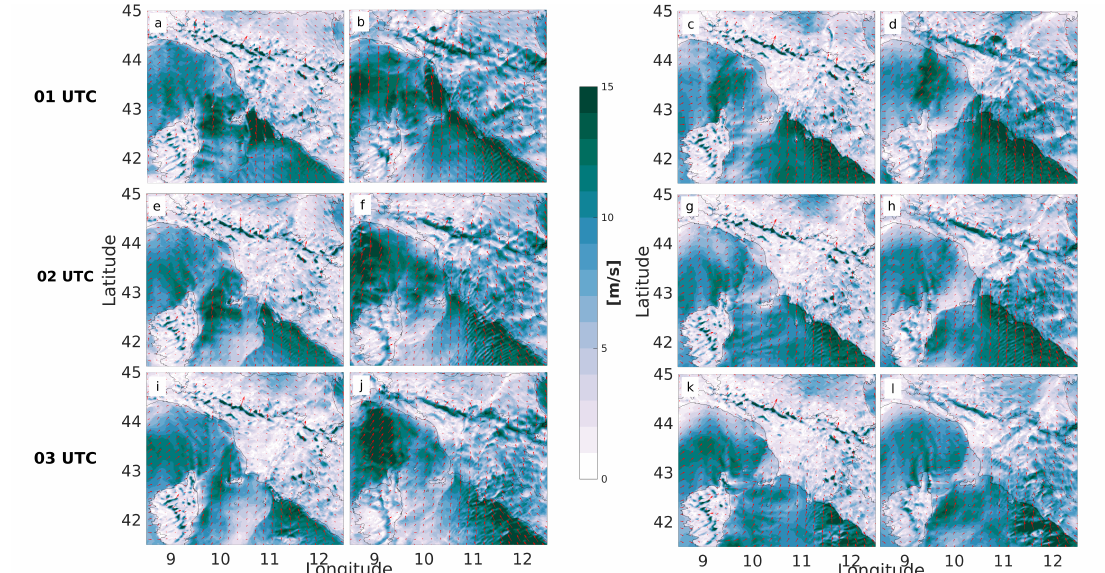
Figure 12. Comparison between the IFS and GFS OL 10 m wind field with respect to the IFS and GFS 3DVAR-WIND 10 m wind field during the entire event duration: 01, 02 and 03 UTC of 10 September 2017. Panels ( a , e , i ) refer to IFS OL, panels ( b , f , j ) refer to IFS 3DVAR-WIND, panels ( c , g , k ) refer to GFS OL and panels ( d , h , l ) refer to GFS 3DVAR-WIND. The red vectors represent wind direction while in colours the wind field intensity is